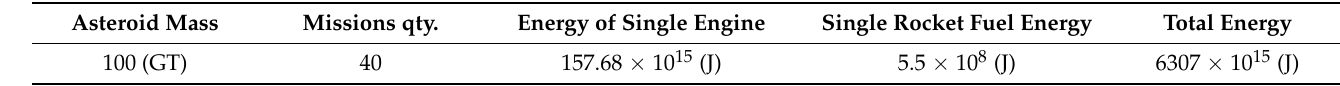
Table 4. Energy costs for partial vaporization of asteroids from Kuiper belt.